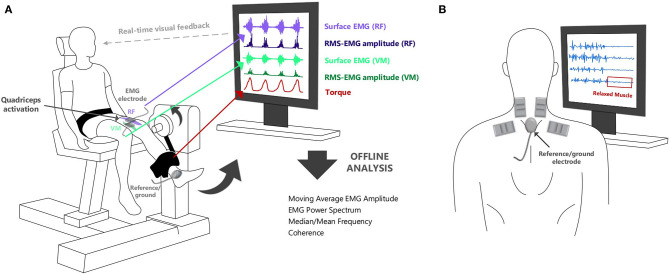
(A) Surface EMG can be used to provide real-time feedback of muscle activation during neuromuscular assessments. It can show the relative timing of activation from selected muscles in different tasks. (B) Visual biofeedback from surface EMG can also aid in muscle training to ensure that rehabilitation tasks are optimally performed (and the correct muscles are “relaxed” or “activated” as required by the task).